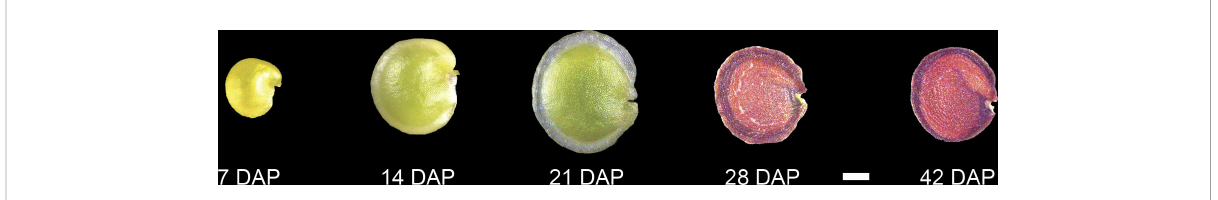
FIGURE 1 Developmental timeline of P. auriculata seed development. Representative seeds from 14, 21, 28, and 42 DAP (days after pollination). Scale bar = 1